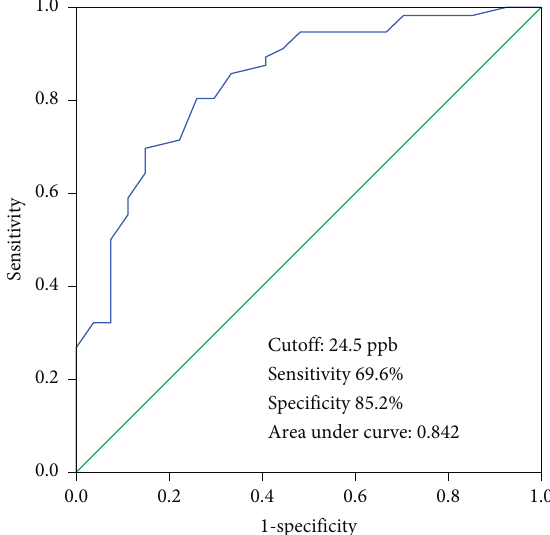
Figure 3: ROC curve showing the diagnostic value of FeNO level for PH in AECOPD